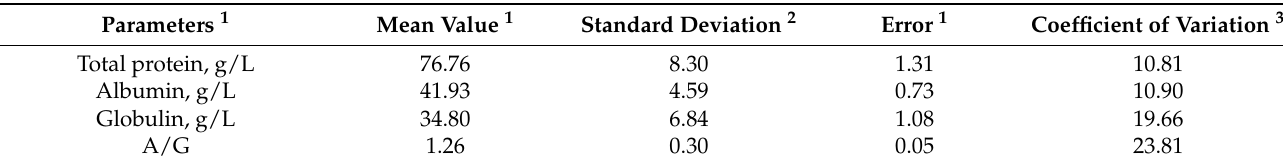
Table 2. Biochemical and antioxidant parameters of the blood serum of the Duroc breed pigs ( n = 40) in group 2 (72 days of